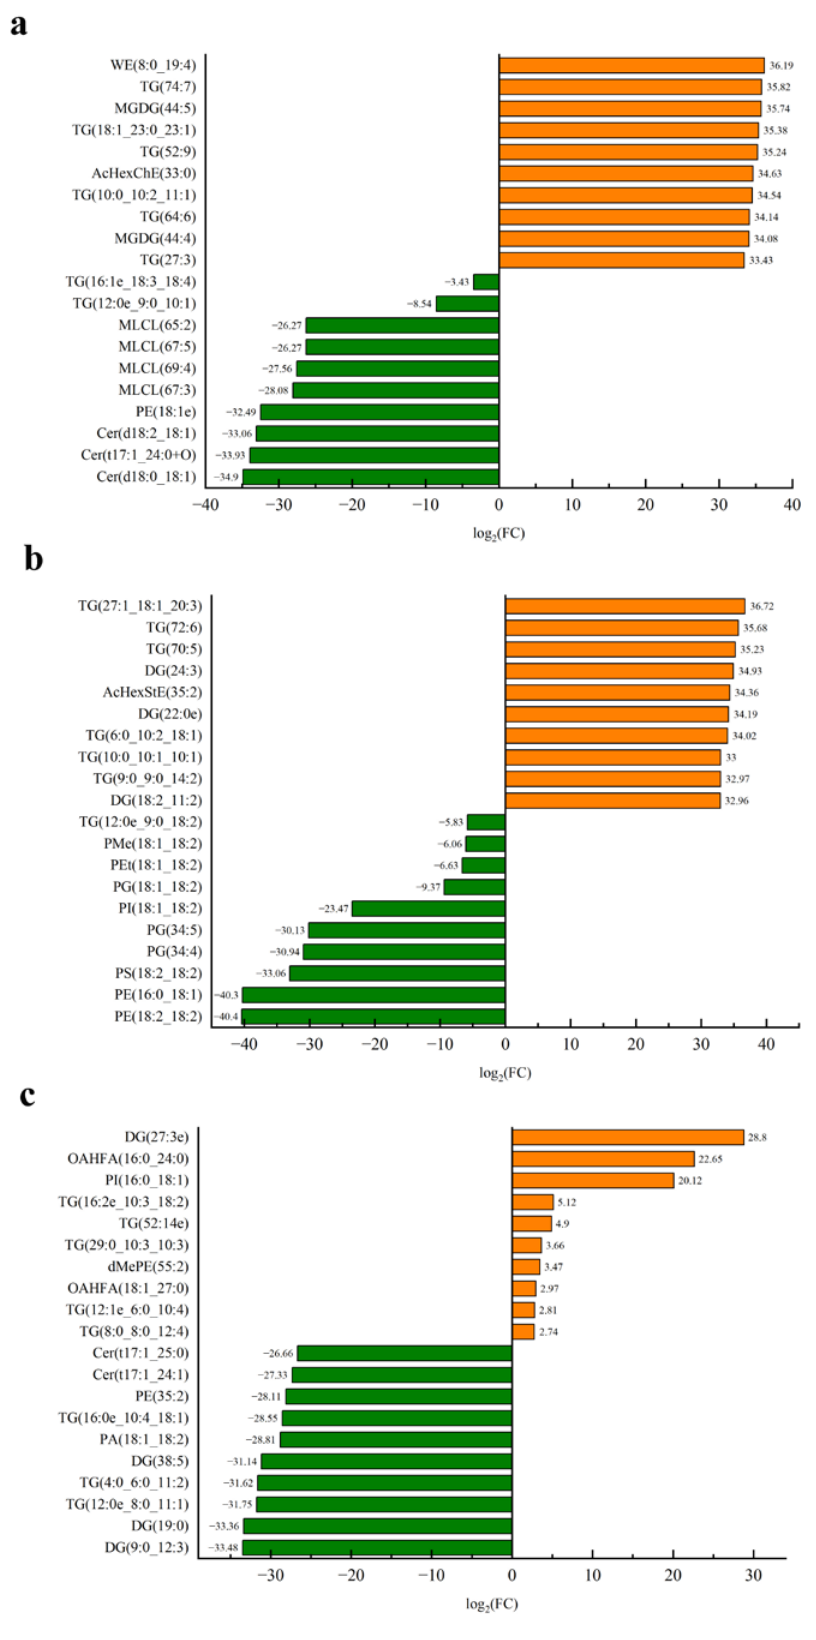
Figure 15. Top 20 lipids of three kinds of camellia oil. ( a ) CO; ( b ) MRO; ( c ) RO.